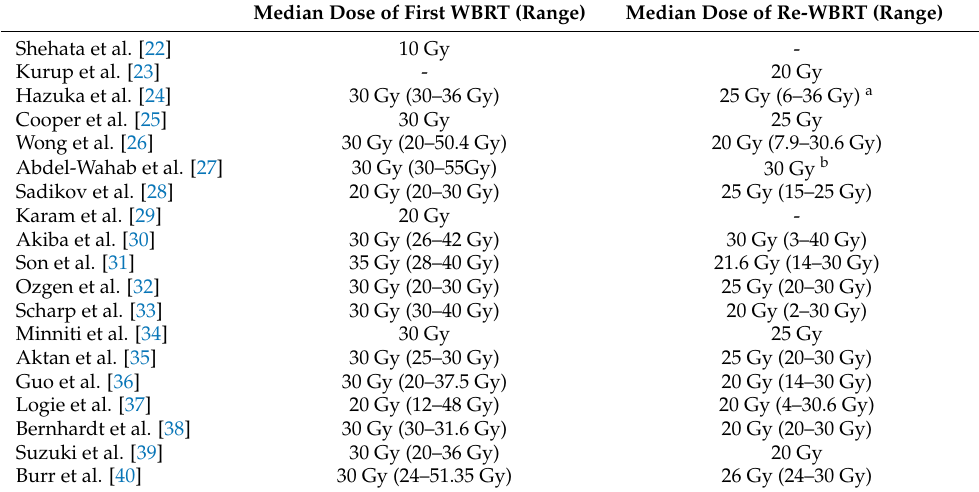
Table 4. Dose parameter of previous reports.